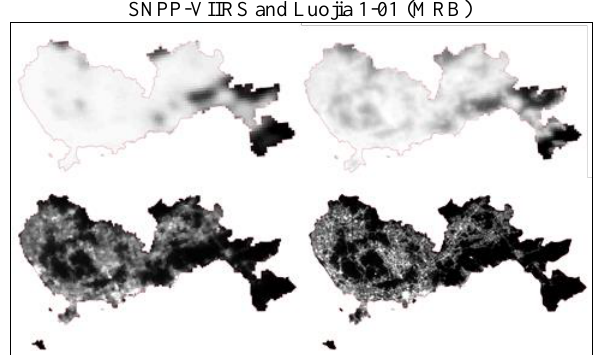
Figure 4. DMSP-OLS, Black Marble, SNPP-VIIRS and Luojia 1-01